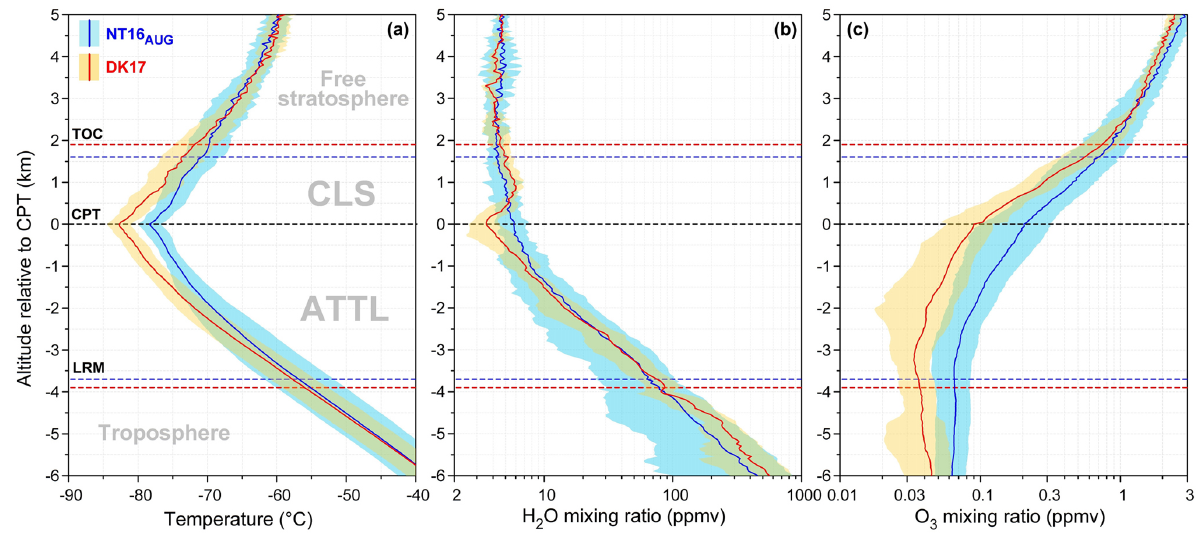
Figure 7. Mean profiles (solid lines) and standard deviations (colored shading) of temperature (a) , the H 2 O mixing ratio (b) and the O 3 mixing ratio (c) as a function of altitude relative to the CPT, for NT16 AUG (blue) and DK17 (red). Dashed lines show the CPT (black) and the average LRM and TOC levels for NT16 (blue) and DK17 (red) (see the labels in a ). The four layers defined in Sect. 5.1 (troposphere, ATTL, CLS and free stratosphere) are identified using grey